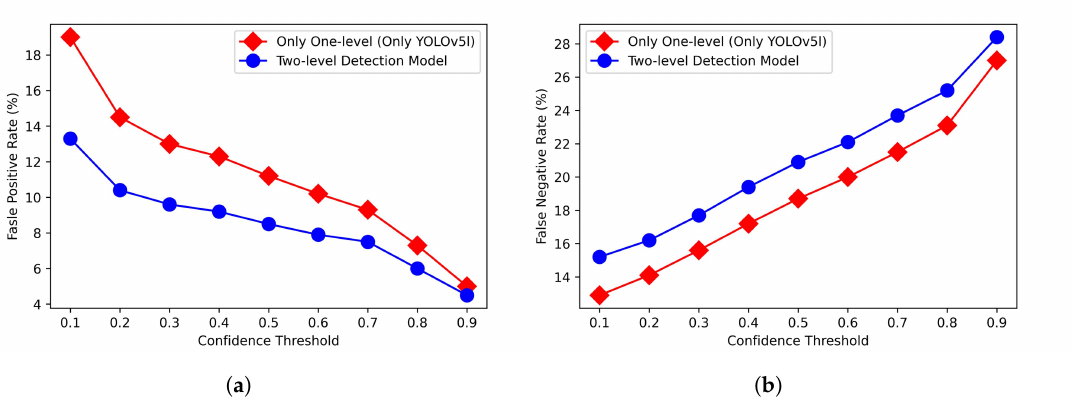
Figure 13. The results of running the two-level disease detection model with different confidence thresholds and only running the first level with different confidence thresholds. ( a ) Comparison of false positive rates; ( b ) comparison of the false negative rates.